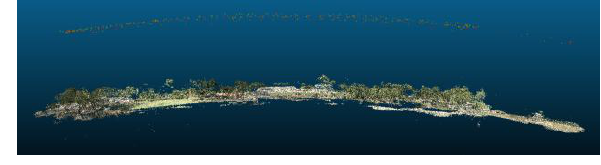
Figure 10. Side view of the point cloud